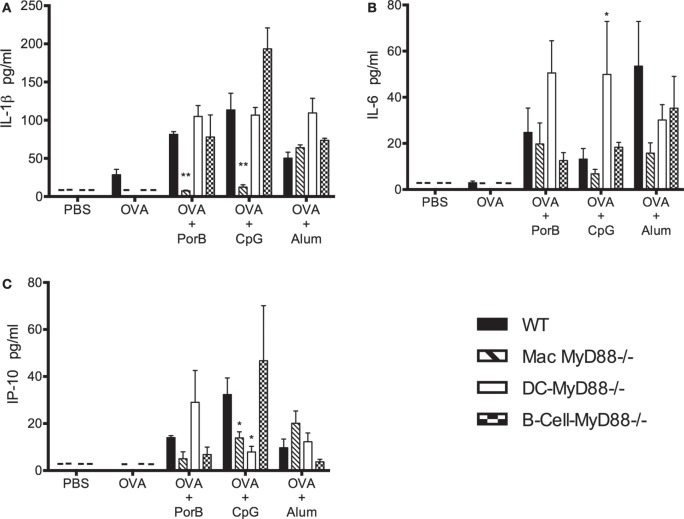
Effect of MyD88 signaling on cytokine induction upon vaccination. In vivo MyD88 signaling is important for the induction of (A) IL-1β, (B) IL-6, and (C) IP-10 cytokines. Serum cytokine levels were determined in vaccinated wild-type (WT), Mac-MyD88−/−, B-cell-MyD88−/−, and DC-MyD88−/− mice immunized two times at 2 weeks interval and serum collected 4 h after of the second immunization with PBS, ovalbumin (OVA), OVA + PorB, OVA + CpG, or OVA + alum measured by Luminex magnetic bead-based multiplex assay. The results shown are representative of one experiment (n = 4 mice); serum was analyzed individually in duplicates. This experiment was repeated twice. Symbol (–) indicates that cytokine levels were below detectable level. One-way ANOVA with Tukey’s test were used to calculate statistical differences between experimental groups and treatments (ns, not significant P > 0.05, *P < 0.05, **P < 0.01). All comparisons were made to WT mice.